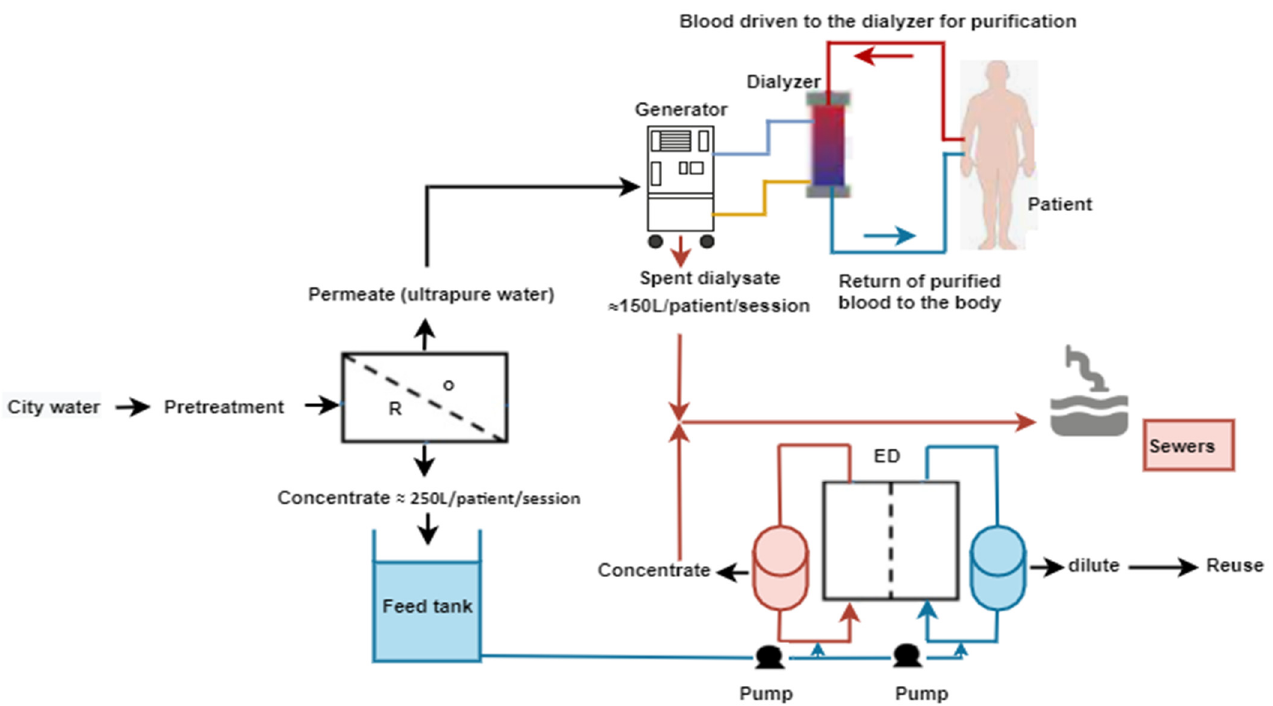
Figure 1. Schematic representation of the hydraulic circuits for the achievement of an hemodialysis session. The hemodialysis machine controls both the extracorporeal circulation and the exchanges through the membrane dialyzer with the dialysate that is prepared on-line by the dilution of concentrate solutions (ionic and bicarbonate) with the ultrapure water prepared in the treatment loop.